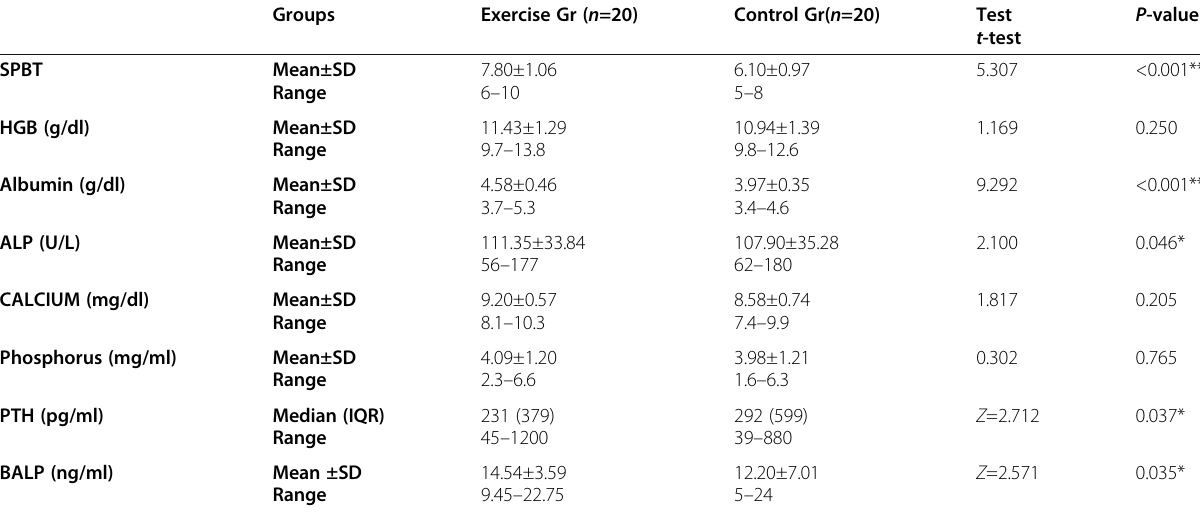
Table 3 Comparison between exercise and control group regarding physical performance scores and laboratory tests after